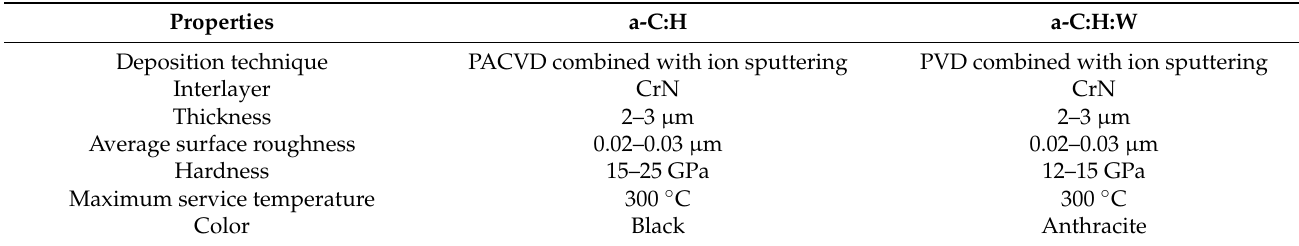
Table 2. Properties of a-C:H coatings.